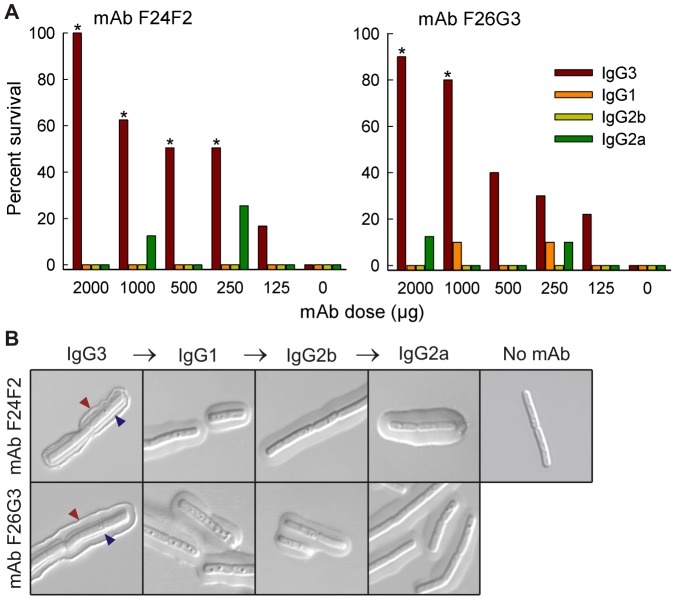
Protection and capsule reactivity of subclass switch families of mAbs F24F2 and F26G3.A – Protection afforded by passive immunization. Mice (n = 8–10 mice/group) were treated with the indicated dose of mAb and challenged 18 h later via the intratracheal route with 10 LD50 of B. anthracis spores (Ames). Statistical comparison of survival of mAb-treated mice vs. control mice given DPBS alone was done with Fisher exact test; * P<0.05. B – Capsule reaction produced by incubation of B. anthracis vegetative cells with mAbs of each subclass (75 µg/ml). Red arrow – outer rim produced on binding of IgG3 mAb; blue arrow – inner binding reaction of IgG3 near the cell wall.